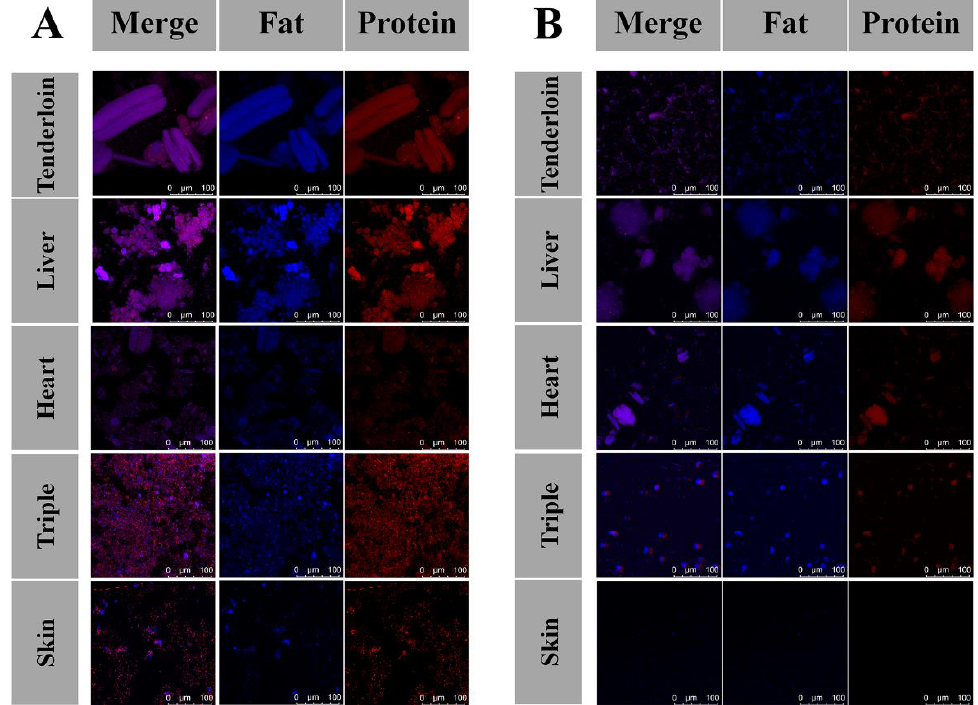
Figure 2. CLSM images of tenderloin and edible pork by-products after gastric digestion ( A ) and after the whole gastrointestinal digestion ( B ).